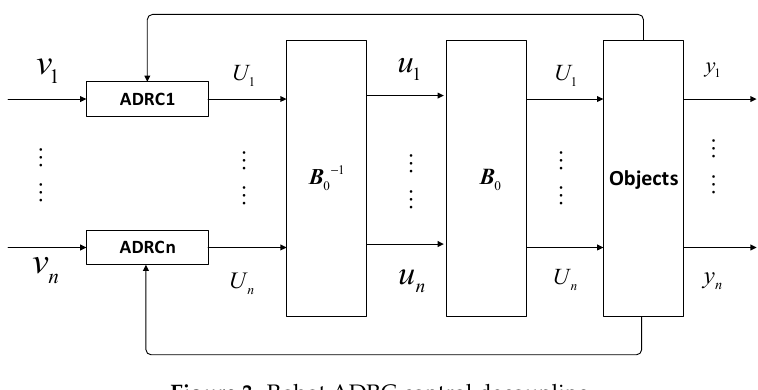
Figure 3. Robot ADRC control decoupling.